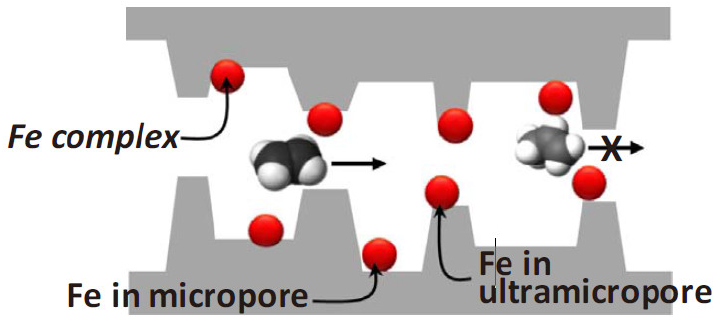
Figure 16. Fe complex in ultramicropores and micropores of Fe-containing CMS membranes. Adopted from [95] with permission. Copyright (2018) Elsevier.